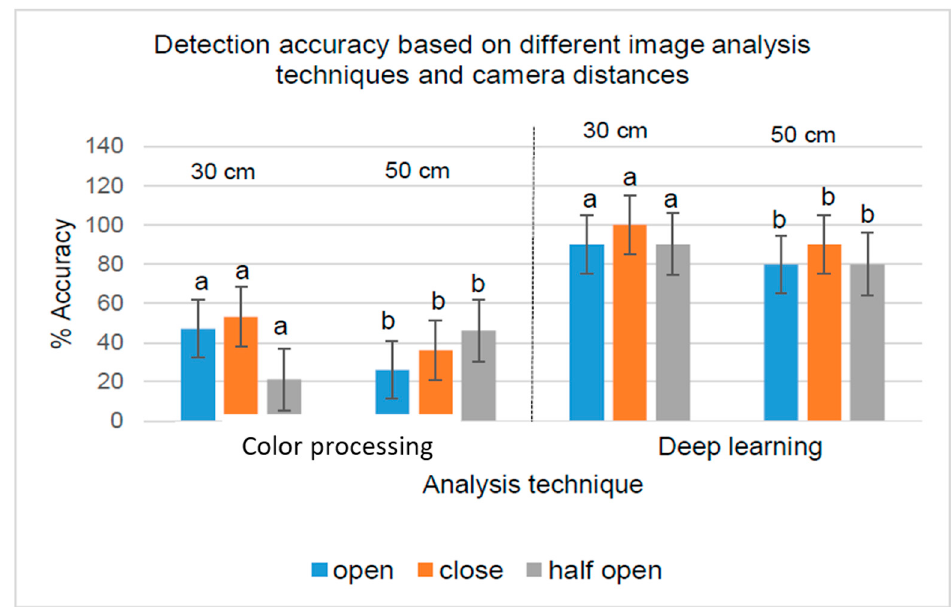
Figure 14. Detection accuracy based on different image analysis techniques according to the Stage 1&2 and Stage 3 methods at different camera distances. Note: Bars across a group with the different letters were significantly different ( p < 0.05) after the LSD test.